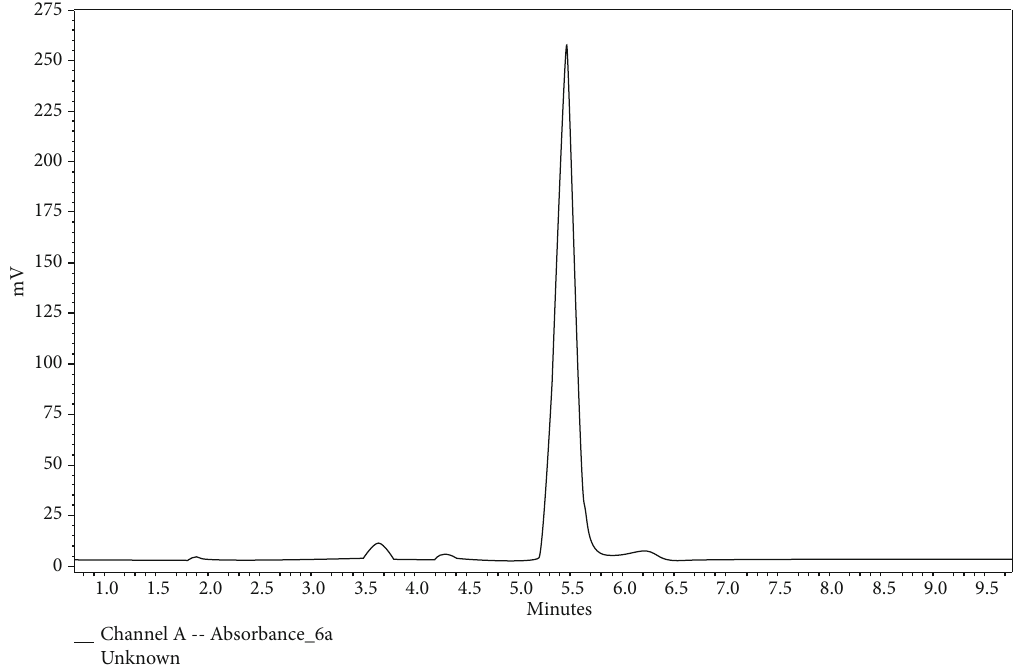
Figure 2: HPLC chromatography of Gambogic acid; chromatographic conditions: the wavelength ( λ ) was set at 360nm. A C ( 150 mm × 4 : 6mm ,5 μ m) was used. The mobile phase utilized was a mixture of methanol: 0.1% acetic acid aqueous solution (93 :7). Column oven temperature was set to 25 ° C. Flow rate was 1.0mL/min, and the injection volume was 20 μ L.